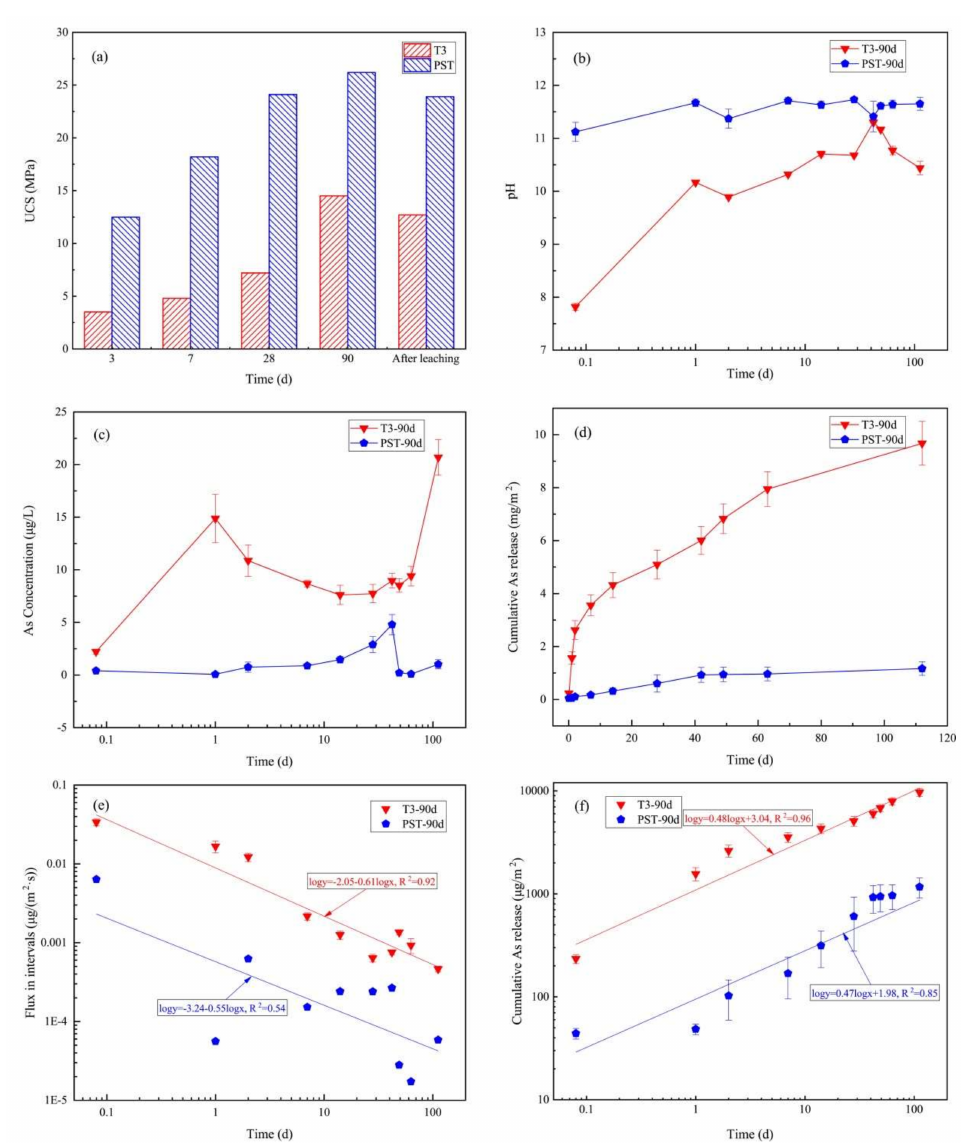
Figure 5. Method 1315 results: ( a ) comparison of UCS values of samples with different curing times to the results after 112 d of semi-dynamic leaching; ( b ) pH; ( c ) As concentration; ( d ) cumulative As release; ( e ) flux in the different intervals; ( f ) log-log plot of cumulative As release over time for T3-90d and